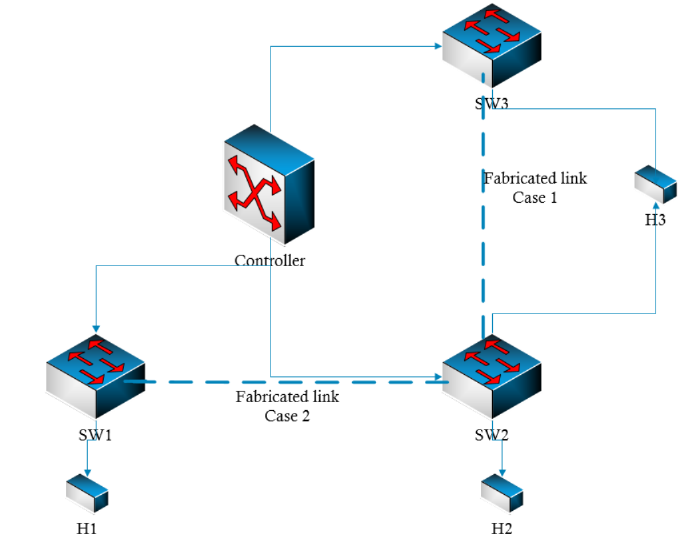
Figure 7. Attack